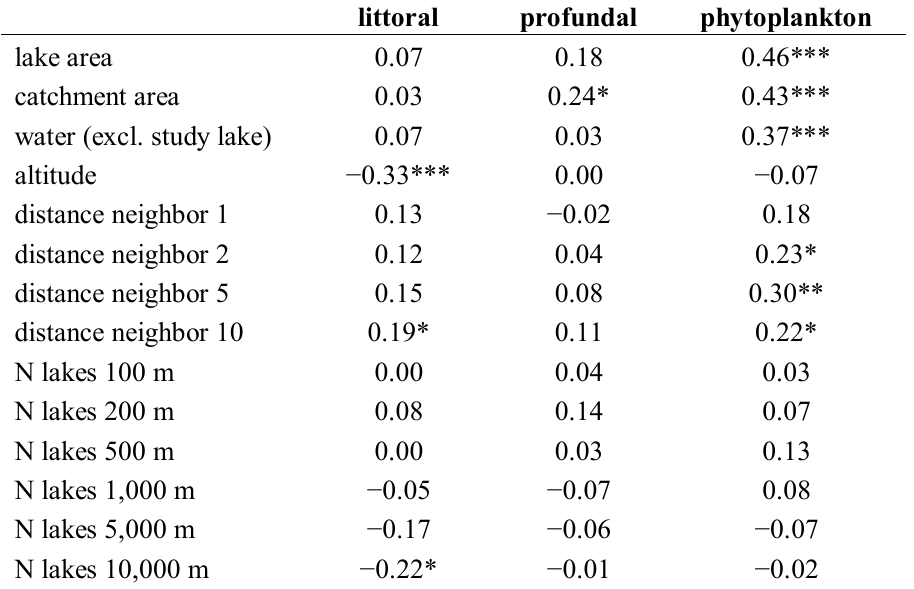
Table 4. Correlations between true positive rate of model predictions and landscape configuration indices. Spearman correlations between the proportion of species found at a lake correctly predicted as present (true positive rate) and indicators of ecosystem size and spatial configuration. Distance neighbor is the distance to the closest and 2nd, 5th and 10th closest neighbor lake and N lakes is the number of lakes with 100, 200, 500, 1,000 and 5,000 m buffer zones round the lake shoreline. Significant ( p ≤ 0.05) correlations in bold. Asterisks indicate significance level: * p ≤ 0.05, ** p ≤ 0.01, *** p ≤ 0.001.